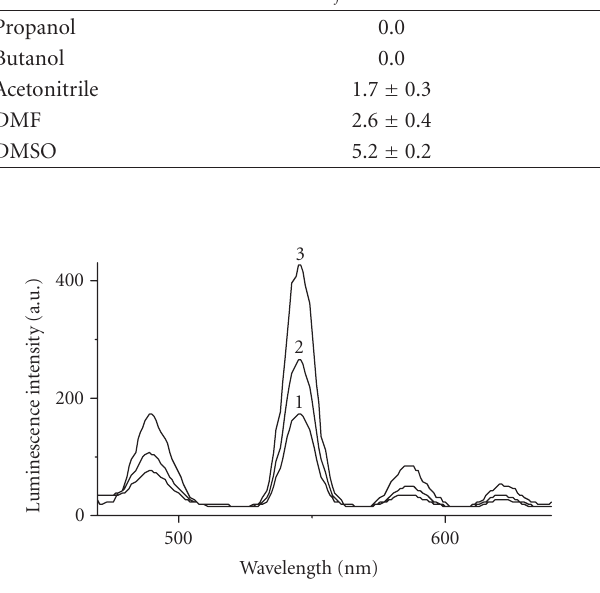
Figure 8: 3D view of the emission spectra of Eu 3+ ion in MC-Eu complex at di ff erent excitation wavelengths in